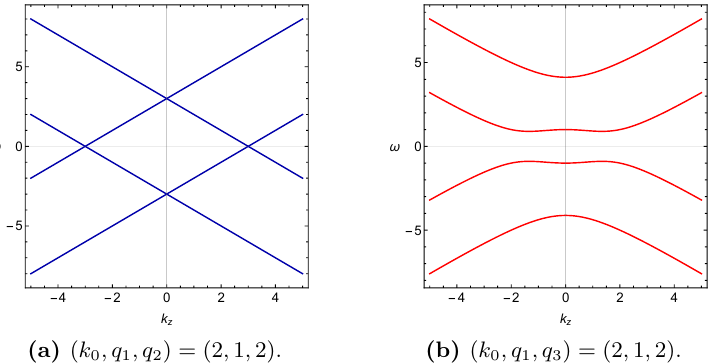
Figure 13. Dispersion curve for m = 0 (a) q 1 ; q 2 6 = 0, (b) q 1 ; q 3 6 =